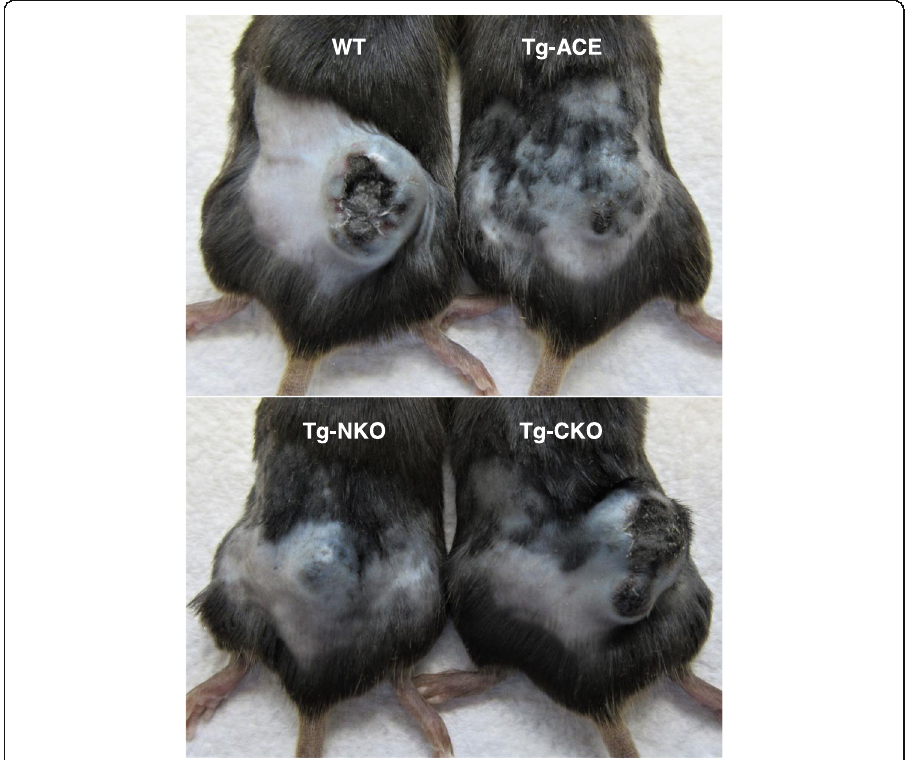
Fig. 3 Melanoma tumor growth. In mice, overexpression of ACE C-domain enhanced macrophage anti- tumor activity. Representative images showing tumor growth at day 14 after intradermal injection of B16- F10 melanoma cells (10 6 cells/mouse) [Cao D-Y et al. Unpublished